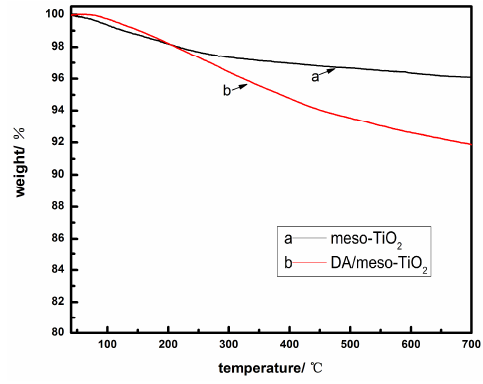
Figure 6. TGA curves of (a) meso-TiO 2 and (b) DA/meso-TiO 2 .